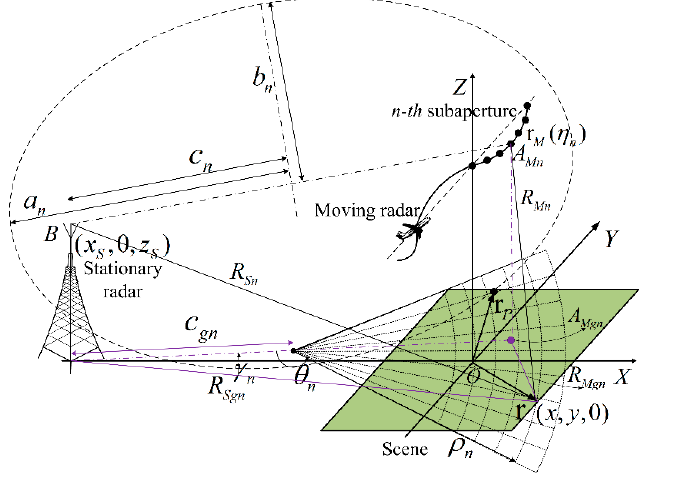
Figure 2. DTDA with the subperture and polar grid processing.